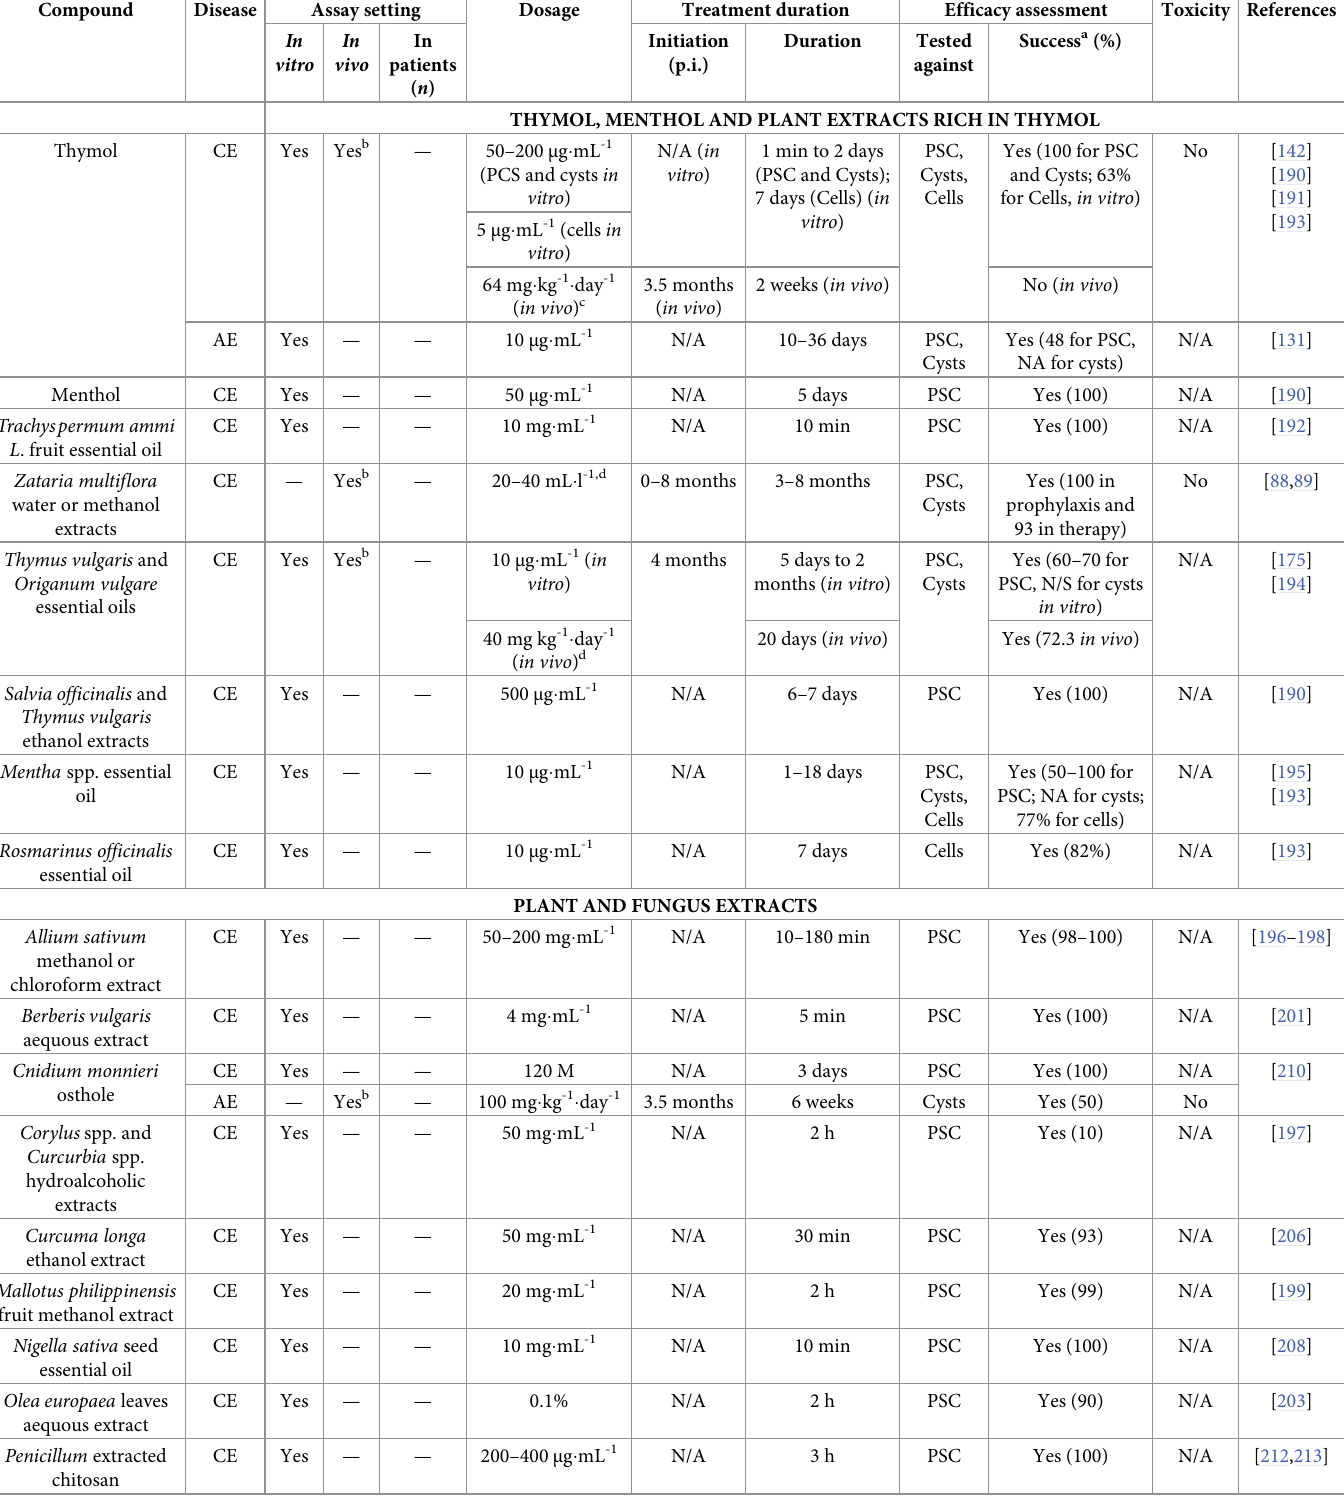
Table 4. Characteristics of natural compounds for the treatment of human cystic and alveolar echinococcosis based on the published literature.